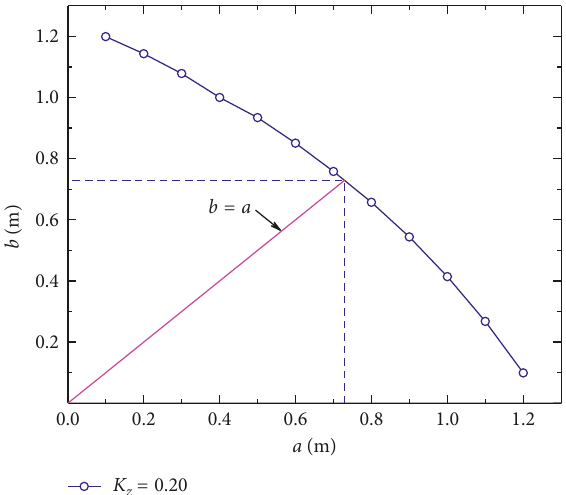
Figure 25: Relationship between a and b .